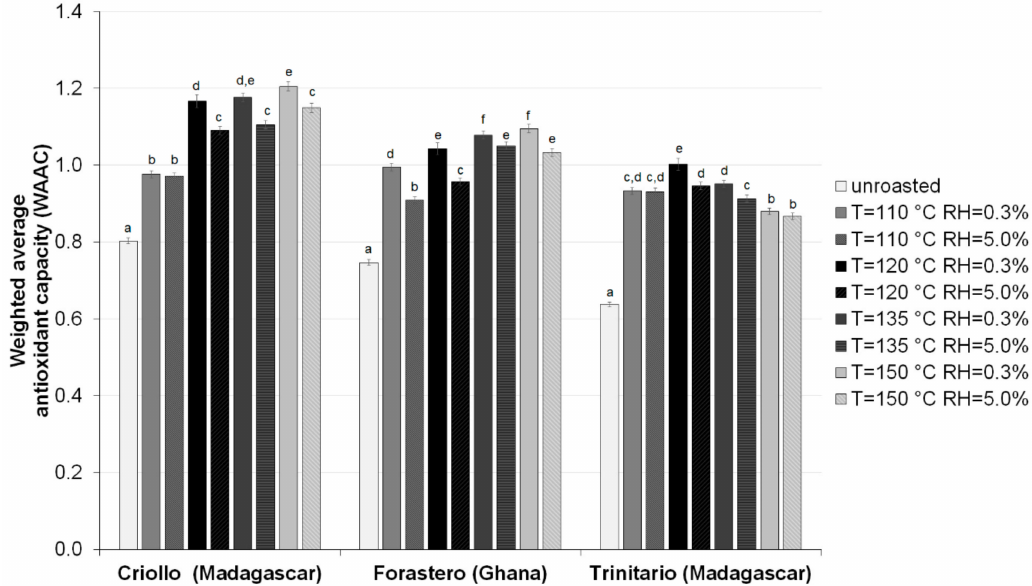
Figure 2. The weighted average antioxidant capacity of HMW fractions isolated from raw and roasted, at di ff erent at di ff erent temperatures and relative air humidities, cocoa beans of di ff erent groups. Results are presented as means ± SD from triplicate assays. Bars with the same lowercase letter (a–f) within each variety do not di ff er significantly according to Tukey’s HSD test at p <